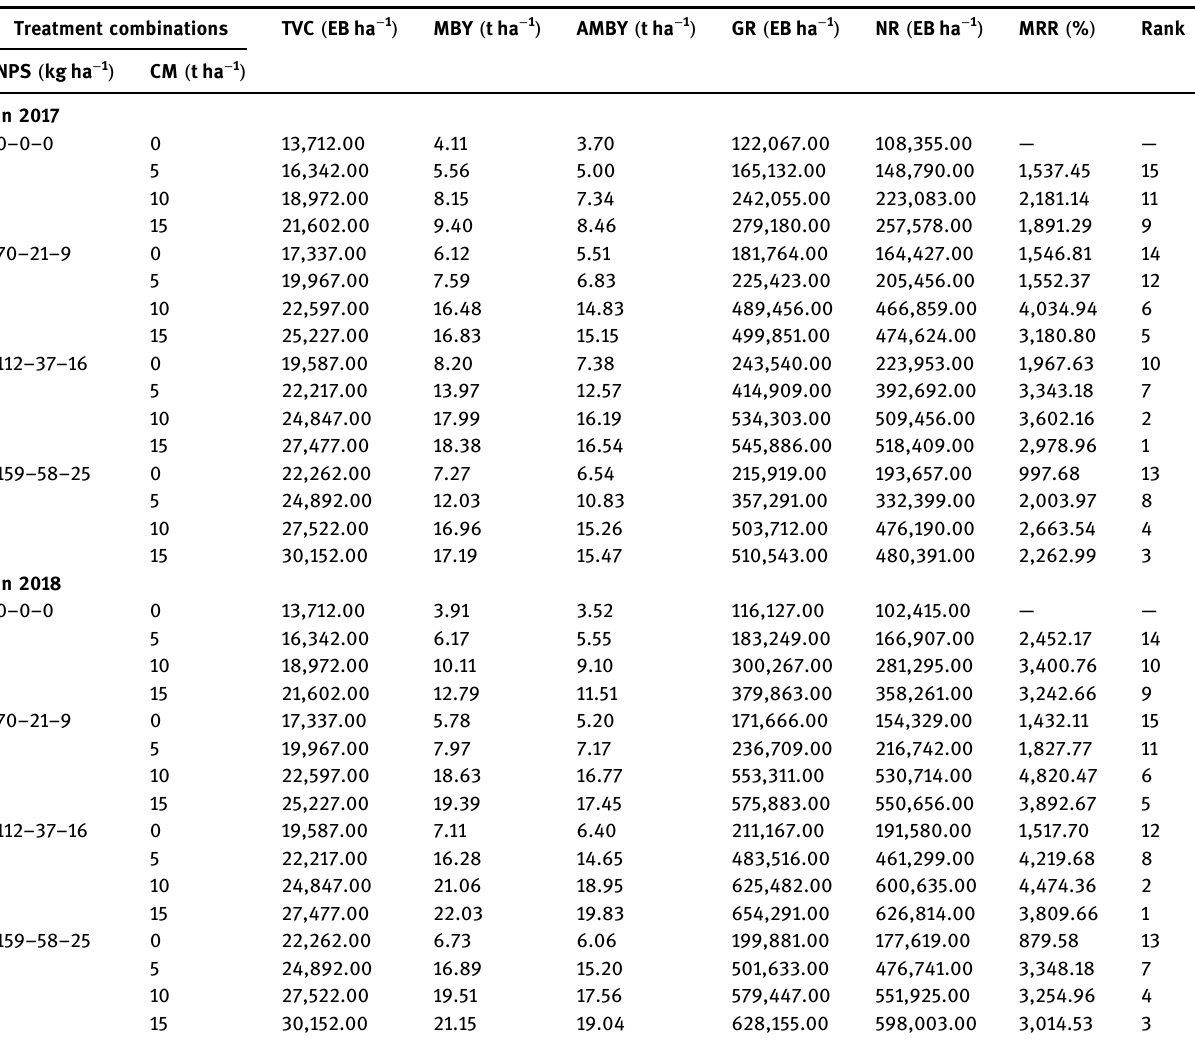
Table 7: Economic return of garlic production as in fl uenced by NPS inorganic fertilizers and cattle manure application in 2017 and 2018 in northwest Ethiopian highlands Treatment